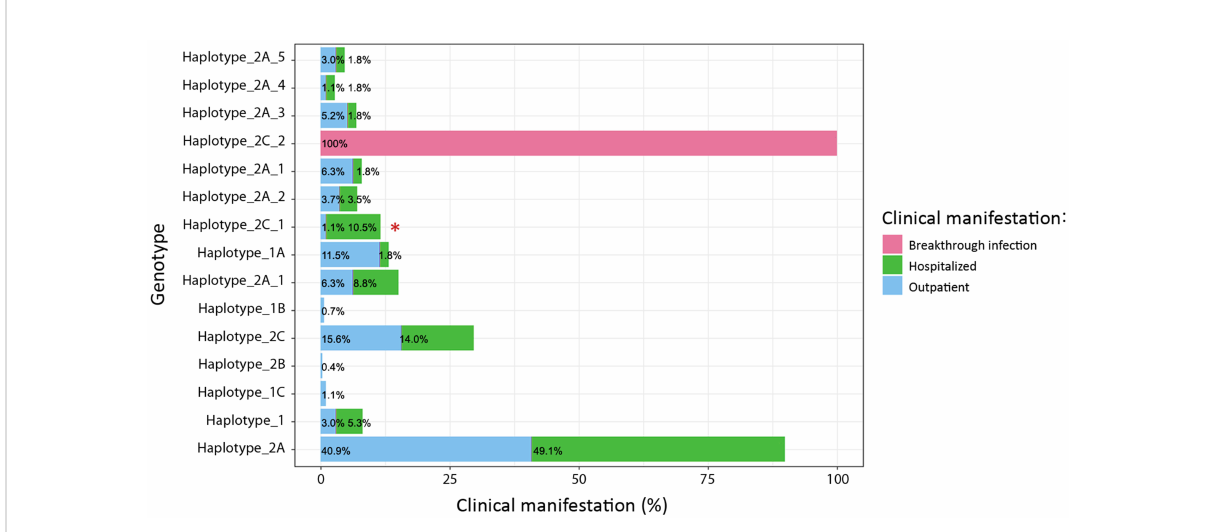
FIGURE 10 Distribuiton of haplotypes between hospitalized patients and outpatients. A statistically signi fi cant difference was observed in the haplotype 2C_1 group (p=0.0013) between hospitalized and outpatients and marked with asterisk